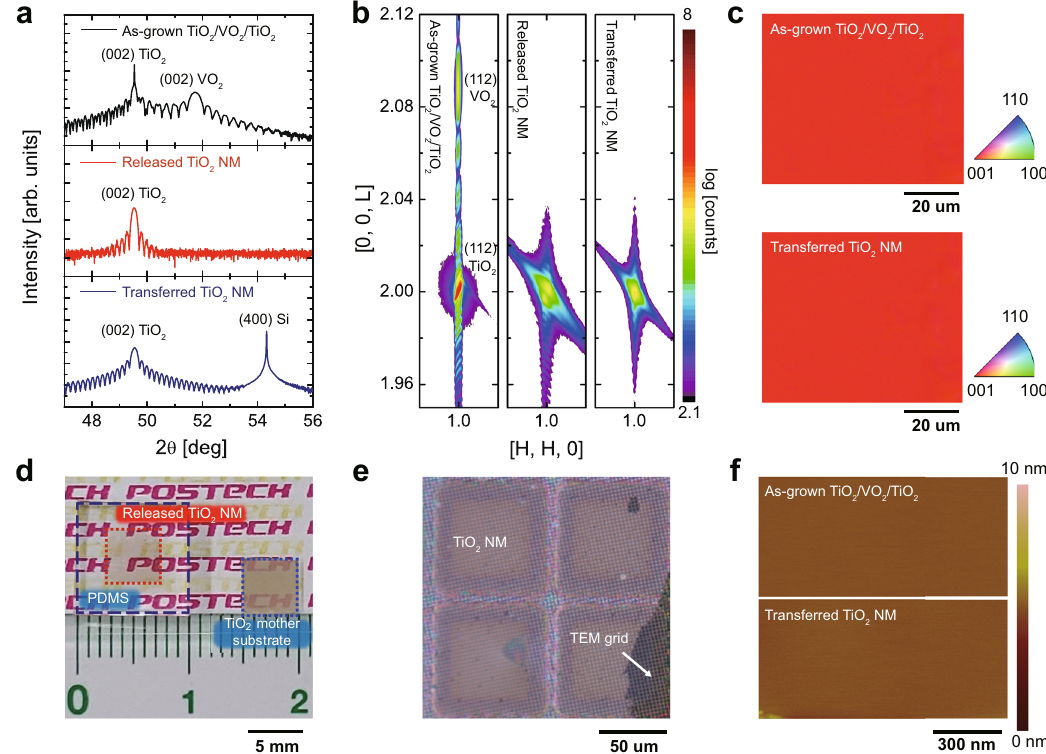
Fig. 2 Crystal and surface quality of released and transferred TiO 2 single-crystal nanomembrane (NM). a Symmetric 2 θ (cid:3) ω scan. b Reciprocal space mapping around (112) re fl ection of as-grown TiO 2 epitaxial fi lms and TiO 2 single-crystal NM released on supporting layer and transferred on Si substrates. The high-resolution X-ray diffraction measurements show single-crystallinity with uniform out-of-plane orientation and no in-plane rotation in released and transferred TiO 2 NM. c EBSD maps of the as-grown TiO 2 epitaxial fi lms on VO 2 /TiO 2 substrates (top) and transferred TiO 2 NM on Si substrates (bottom), con fi rming the single-crystalline out-of-plane orientation. d Photograph of 40-nm-thick TiO 2 single-crystal NM released on mechanical support with the identical lateral dimension with TiO 2 host substrates. e OM image of transferred TiO 2 NM on the carbon TEM grid. f AFM image of as-grown TiO 2 fi lms and transferred TiO 2 NM, which con fi rms a uniform and fl at surface without surface cracks or